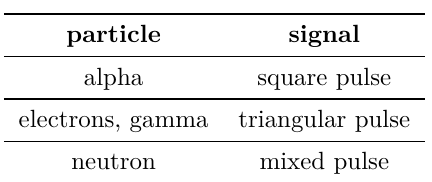
Table 1. Signal shape for different